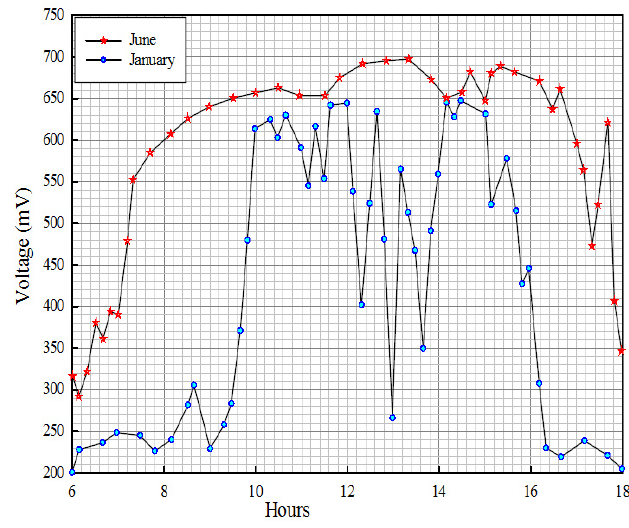
Figure 7. The hourly electric production in January and June (for one element).